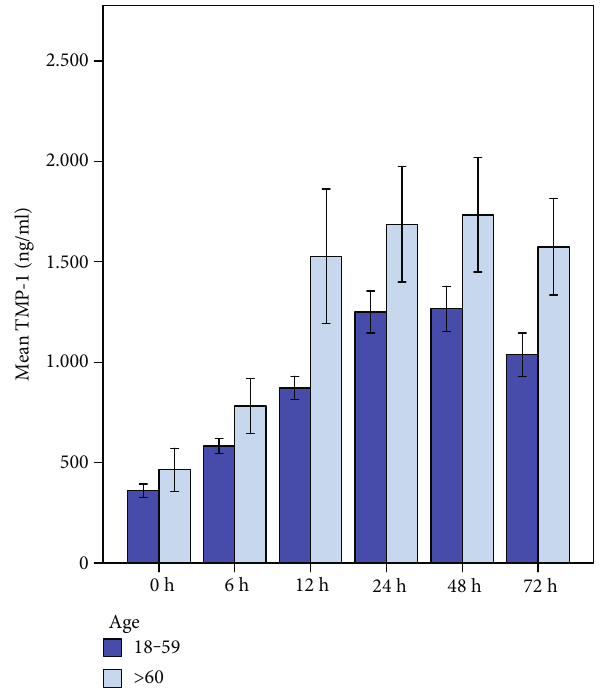
Figure 7: MMP-9 serum levels over the fi rst 72h after trauma correlated to patient ’ s age. Multivariate analysis of concentration kinetic of MMP-9 and time after trauma revealed a highly statistical signi fi cance ( p < 0 : 001 ) in both groups. General linear regression model (test of between-subject e ff ects) revealed no statistical signi fi cance for MMP-9 serum levels and age ( p = 0 : 227